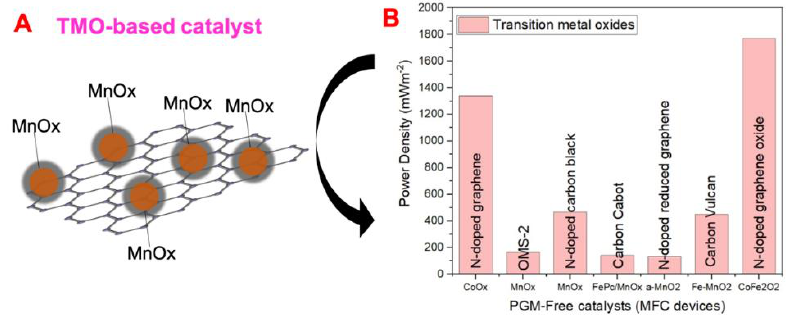
Figure 5. Schematics of a carbon supported MnOx-based catalyst ( A ) and performance (in terms of peak power density) of different type of TMO catalysts in air-cathode MFC devices ( B ).